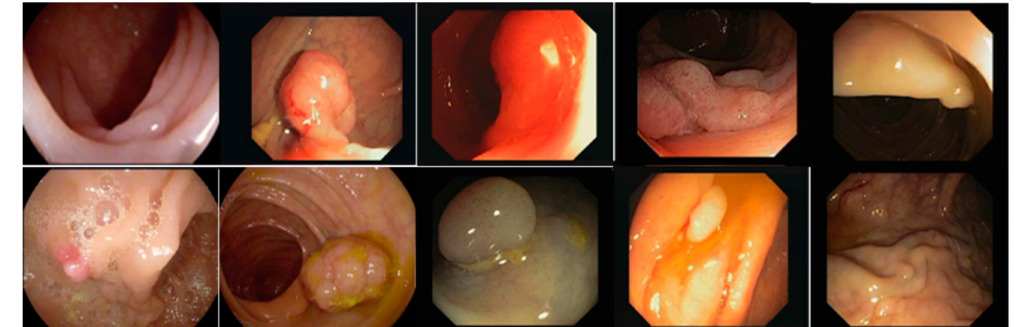
Figure A1. Samples of colonoscopy images with a variety of polyp conditions.